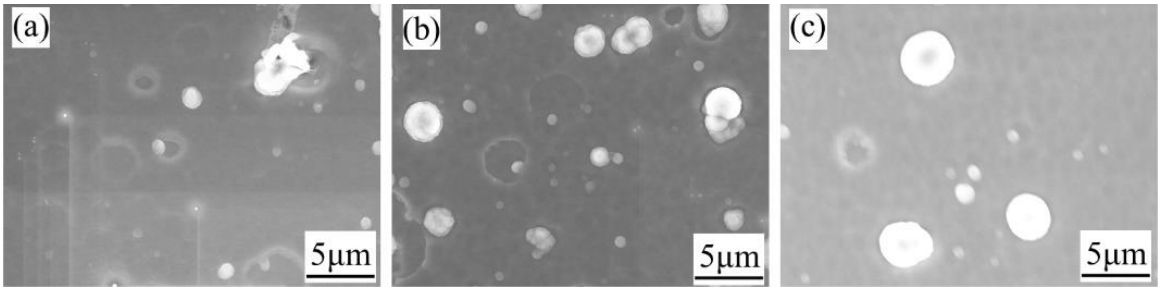
Figure 1. SEM of Si-DLC with different transition layers: ( a ) AlTiSiN/Si-DLC; ( b ) AlCrN/Si-DLC; ( c ) AlTiCrN/Si-DLC.